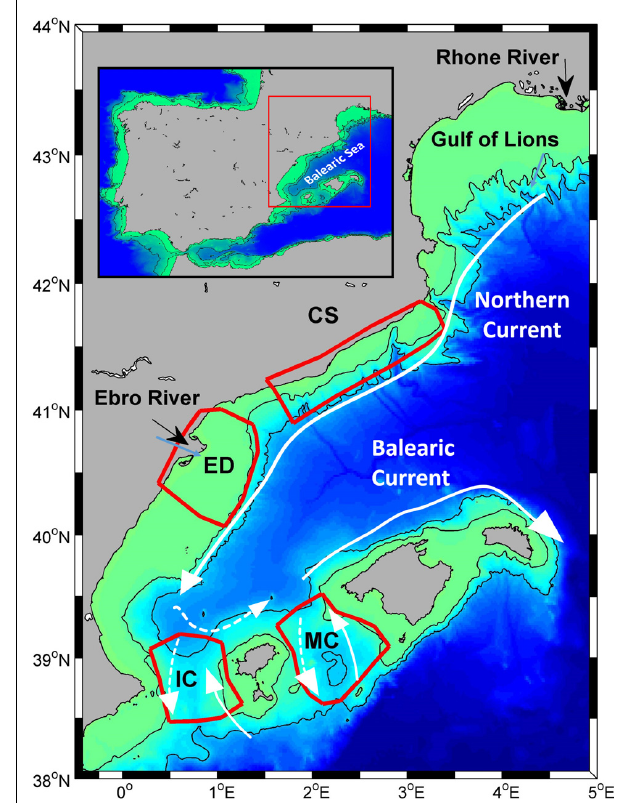
FIGURE 1 | Domain of the study, areas where specific analyses were conducted, and main currents. CS, Catalan Shelf; ED, Ebro Delta; IC, Ibiza Channel, MC, Mallorca